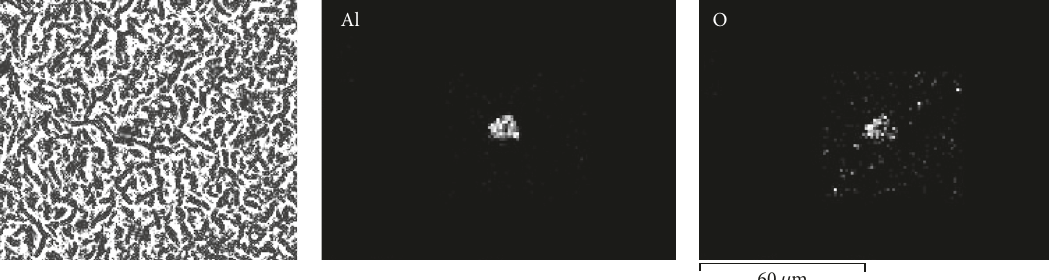
Figure 4: SE image and EDS maps of aluminum and oxygen distribution for the left breakdown site in Figure